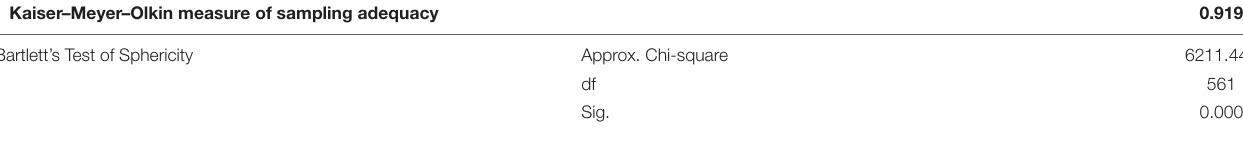
TABLE 3 | Kaiser–Meyer–Olkin (KMO) and Bartlett’s